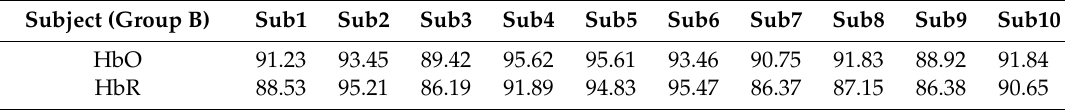
Table 7. The classification accuracies of the mean-peak combinations by Group